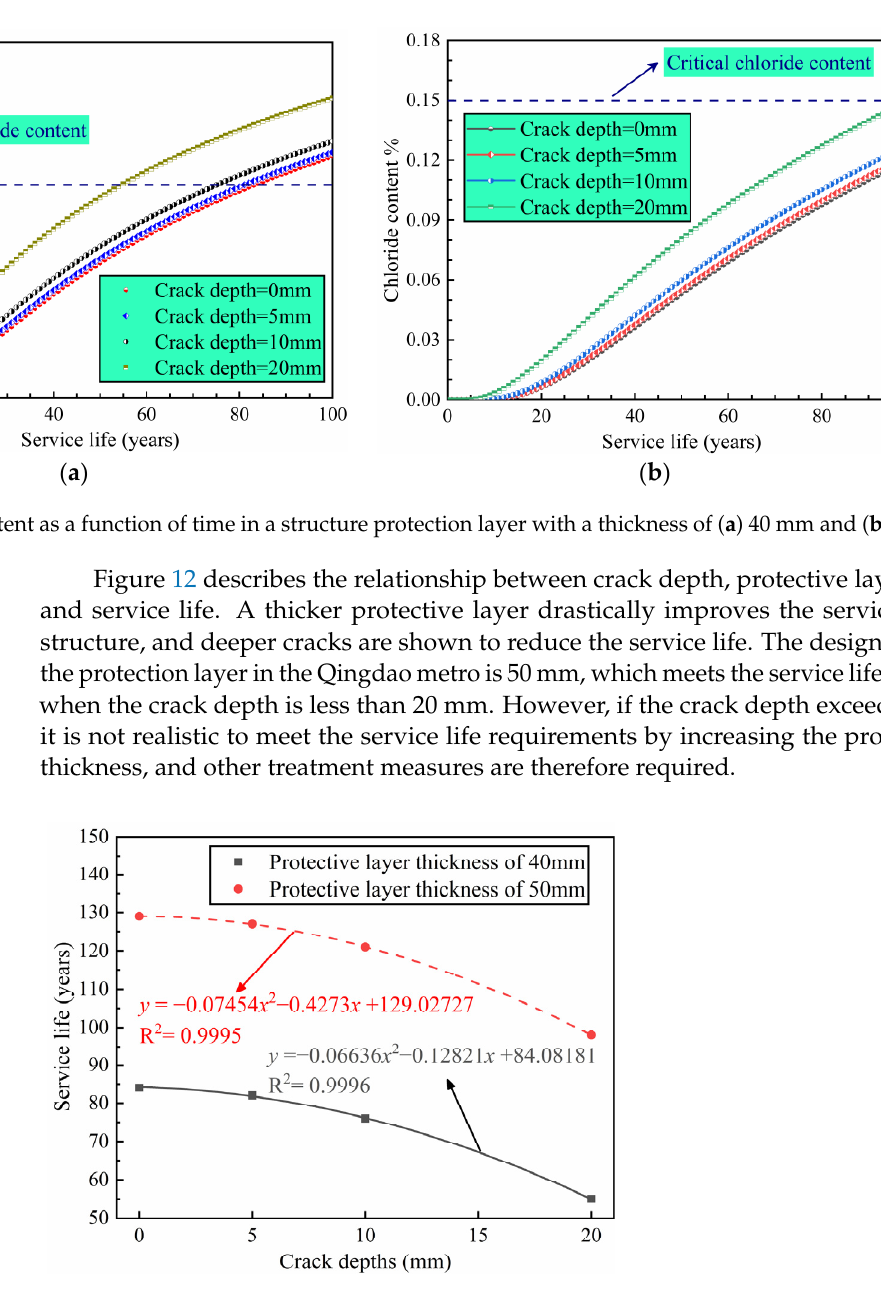
Figure 13. Grouting of a void behind the lining. 4.2. Lining Surface Cracks For cracks on the surface of a subway lining, a wedge-shaped groove can be used in the cracked area to cut the groove inlay treatment. Epoxy resin mortar can be injected into the cracks by applying a certain grouting pressure to the grouting pipe to fill the crack gap, as shown in Figure 14a. In the case of water seepage in the cracked area, the cracks